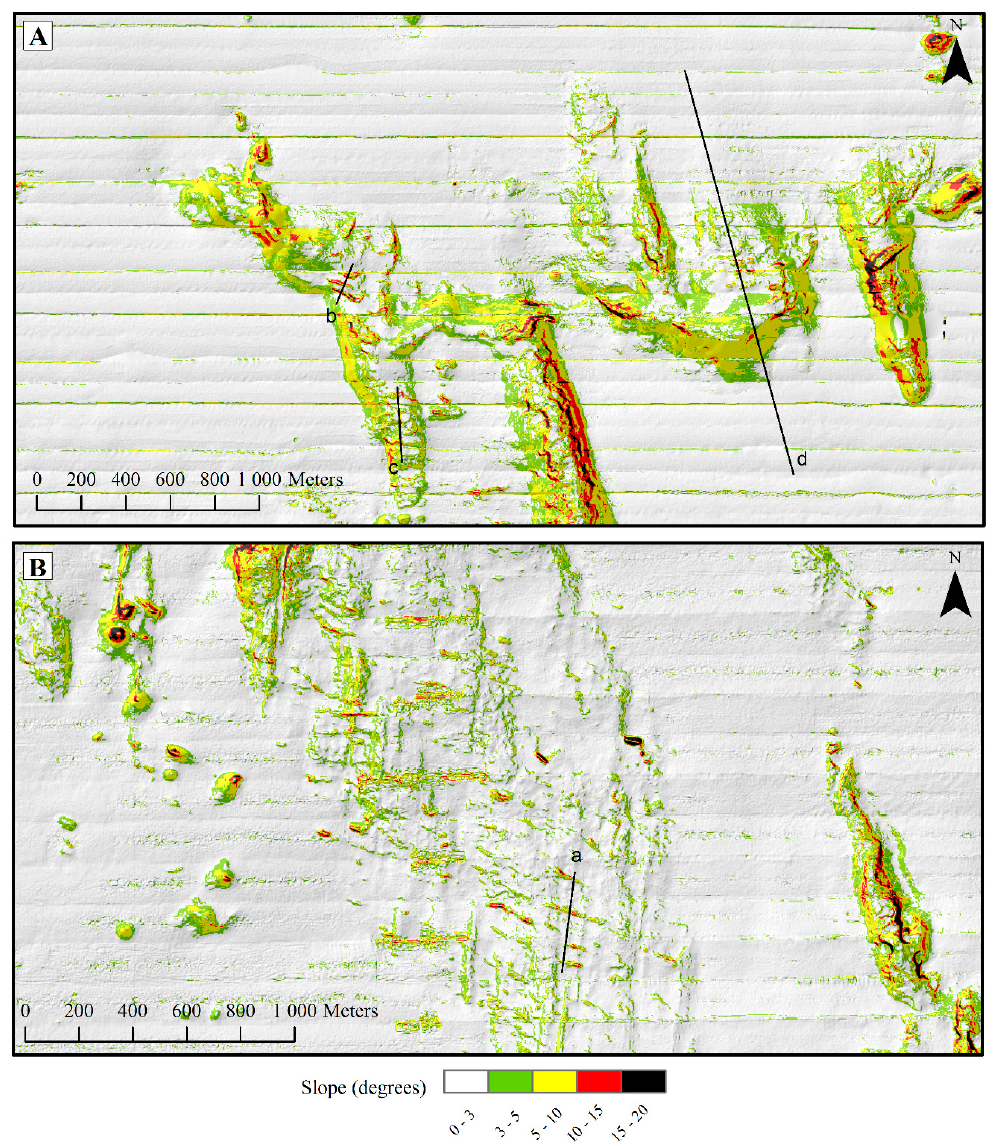
Figure 7. Slope in degrees ( A ) Moschny Island key area; ( B ) Vyborg key area. See Figures 5 and 6 for the locations of Profiles A–D. The colour ramp has been selected to highlight the main features of the